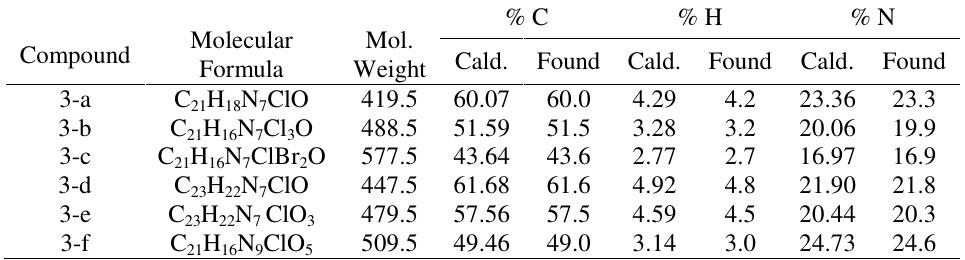
Table 1. Analysis of synthesized